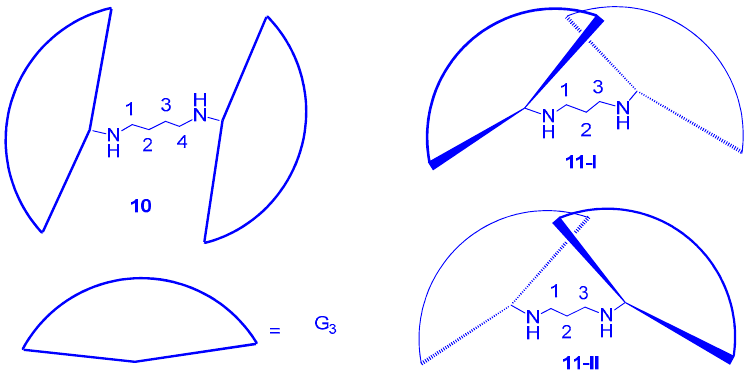
Figure 6. Isomers of dendrimers ( 10 ) and ( 11 ).